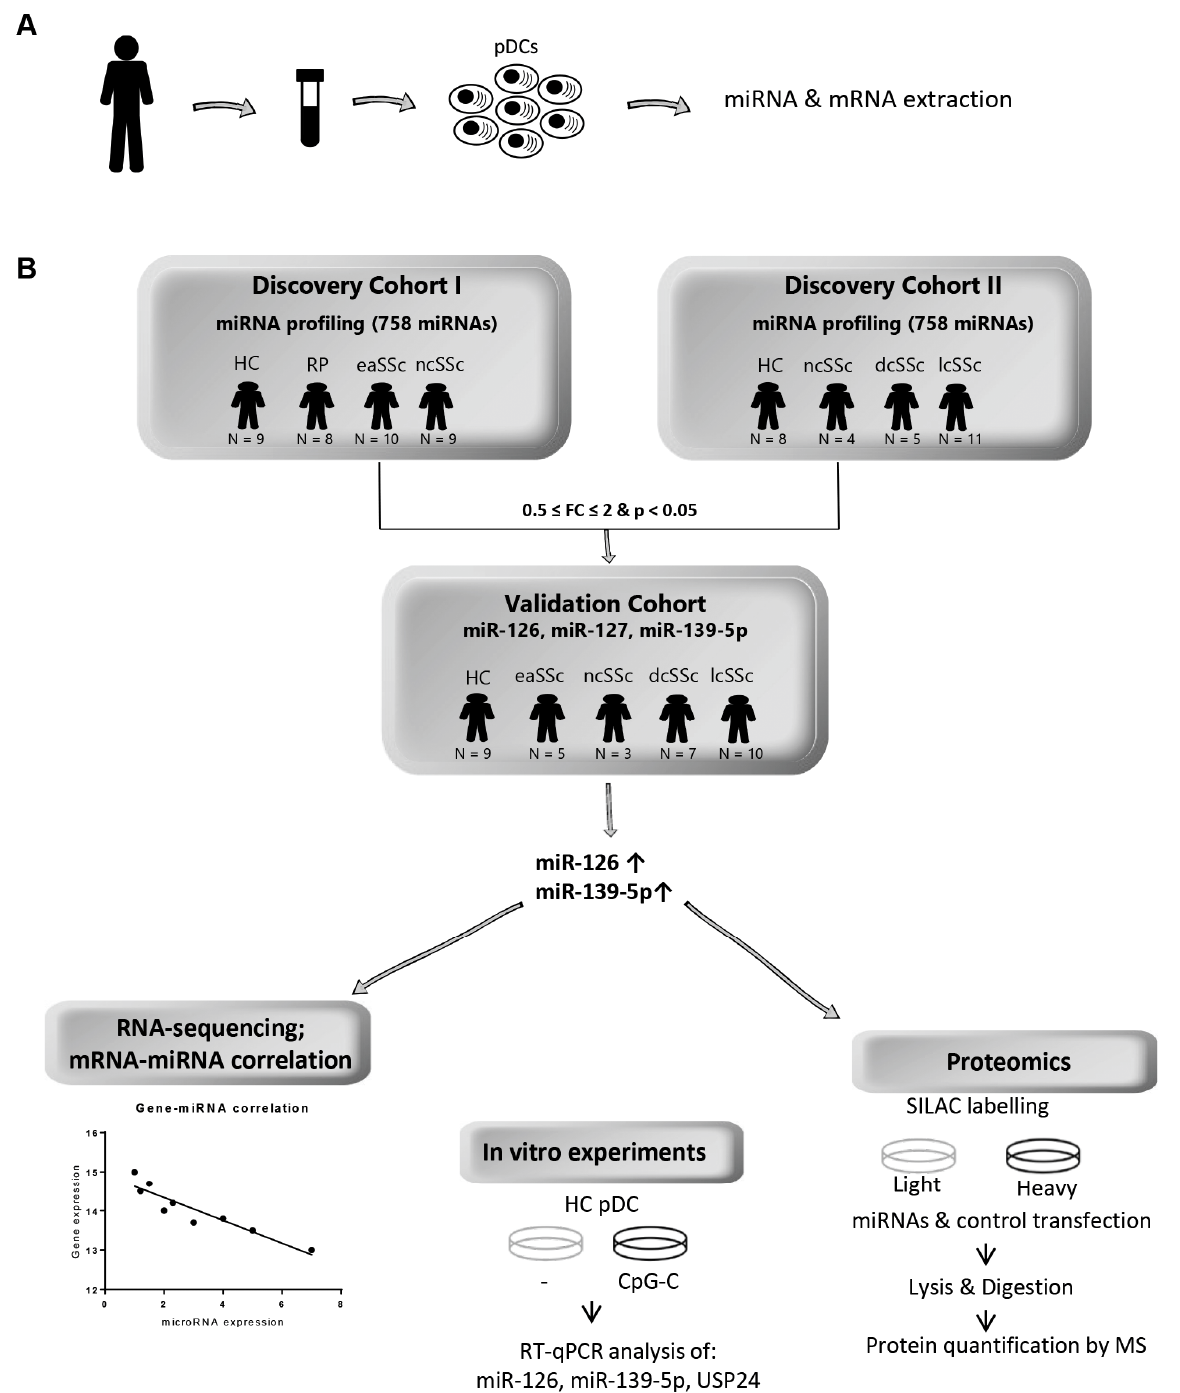
Figure 1. Schematic design of the study. ( A ) Peripheral blood plasmacytoid dendritic cells (pDCs) were isolated from three independent cohorts of SSc patients ( n = 72) and matched healthy donors ( n = 26), and RNA was extracted for further miRNA analysis and RNA sequencing. ( B ) A qPCR-based array was used to determine the expression of 758 miRNAs in discovery cohort I and II, while the transcriptome profile of the same cells was determined using RNAsequencing. Two independent experiments were performed for both miRNA screening and RNAsequencing. MicroRNA profiling was analyzed using ExpressionSuite Software (independent t-test, uncorrected p -value < 0.05). For RNA sequencing, differential gene expression analysis (adjusted p -value < 0.05) was performed with DESeq2, and the read counts were normalized using variance stabilizing transformation to obtain normalized read counts. Stable isotope labeling of amino acids (SILAC) followed by proteomic analysis was used to assess the protein targets of miR-126 and miR-139-5p. These miRNAs were further correlated with RNA sequencing data. HC, healthy control; RT-qPCR, Real-Time quantitative PCR; MS, mass